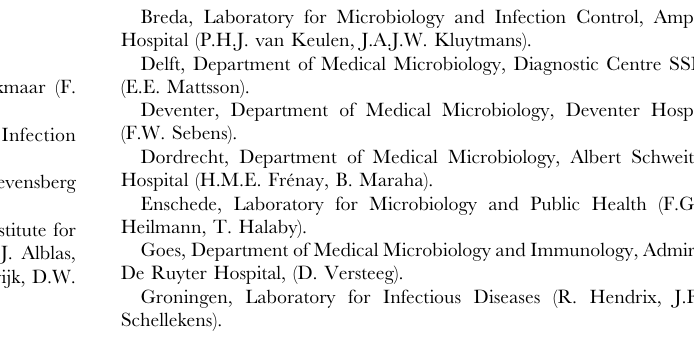
Table 3. The average probability of inadequate coverage, including range, for gram-negative uropathogens (see table 1) in different hospital settings*, ISIS-AR, the Netherlands